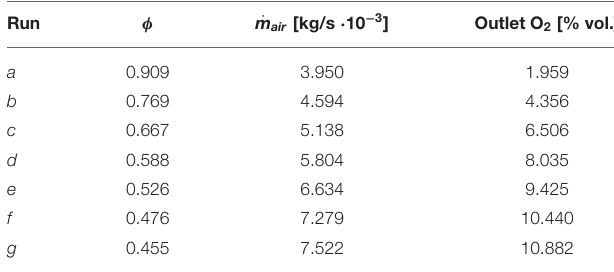
TABLE 1 | Operating conditions investigated by Veríssimo et al. (2011). Run φ Outlet O 2 [%